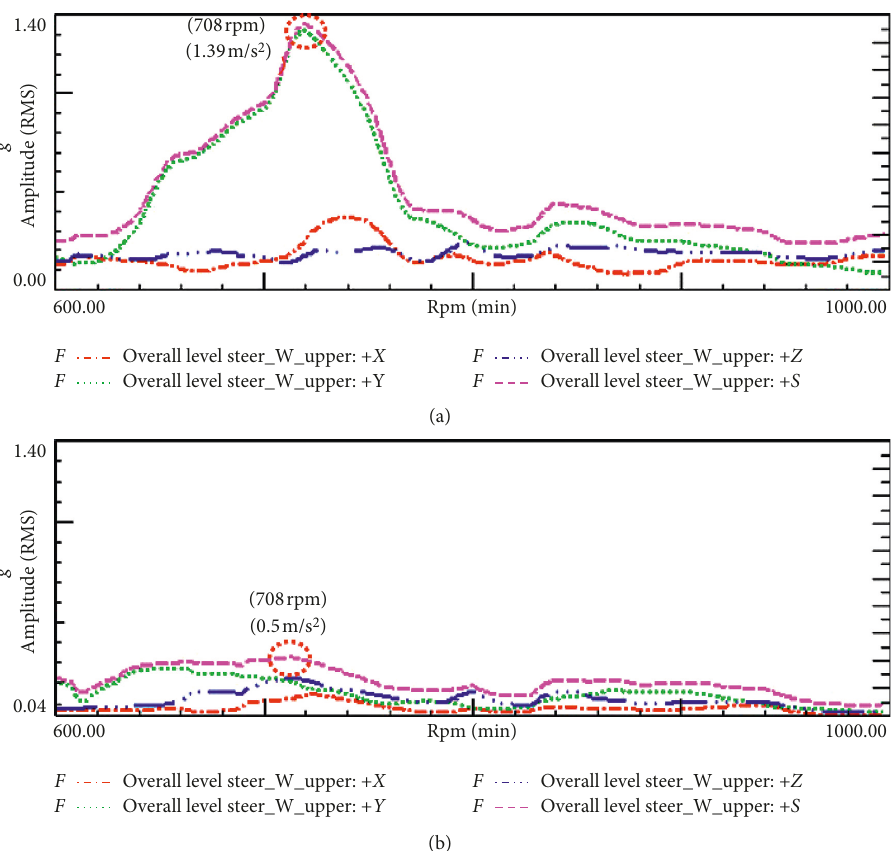
Figure 23: The vibrational spectrum of the upper end of the steering wheel in three directions: (a) vibration response of original steering wheel; (b) the vibration response of steering wheel after the improvement (sampled by per